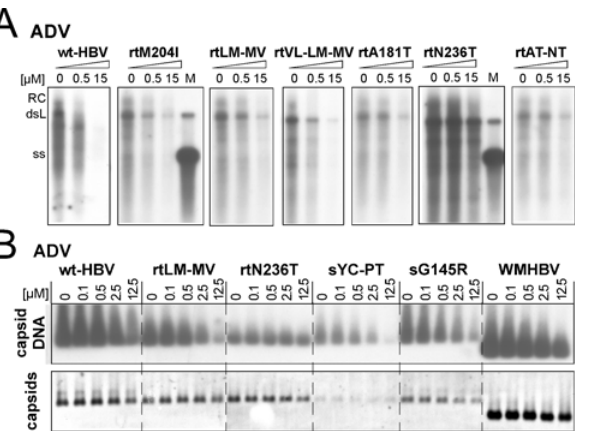
Fig 4. Pronounced resistance of cell line-borne HBVs carrying established ADV resistance- associated mutations against pure ADV. The indicated cell lines were treated with pure ADV at the indicated concentrations. Drug susceptibility was assessed by Southern blotting (A) and NAGE blotting (B). Note the marked loss of capsid DNA signals but at most slight decrease in capsid signals at the highest ADV concentration for all cell lines except the rtN236T line. EC 50 values for all cell lines are provided in Table 2.